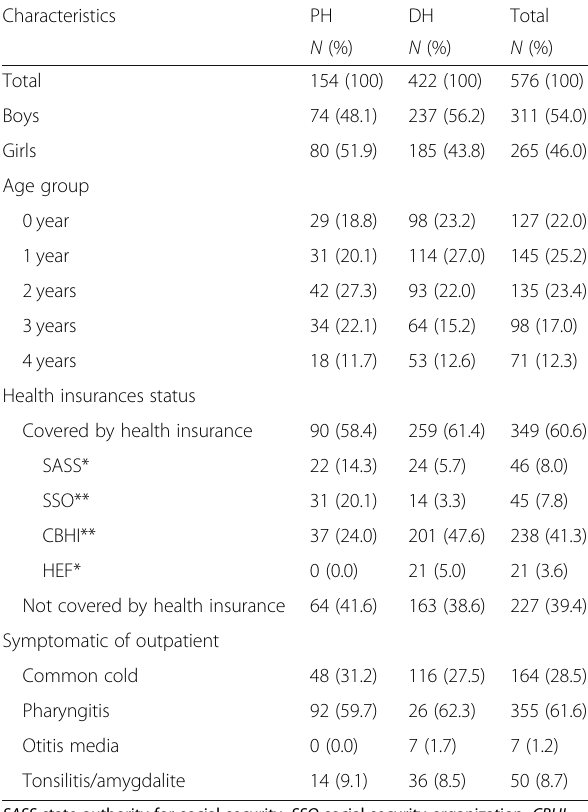
Discussion Usage of the guideline